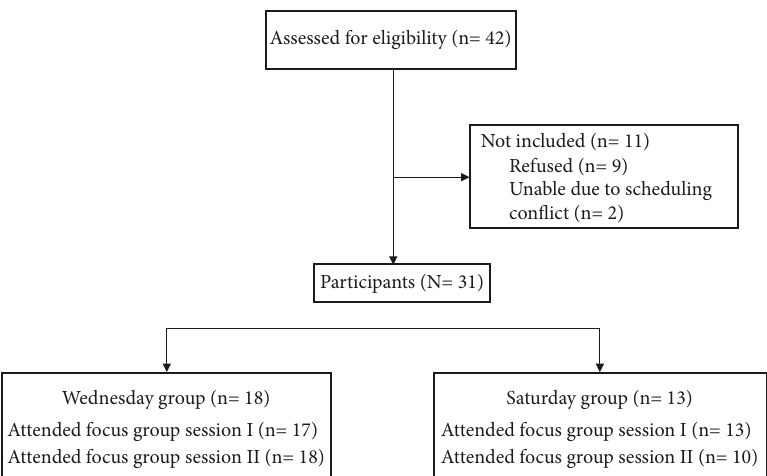
Figure 2: Recruitment, enrollment, and participation in focus group sessions.